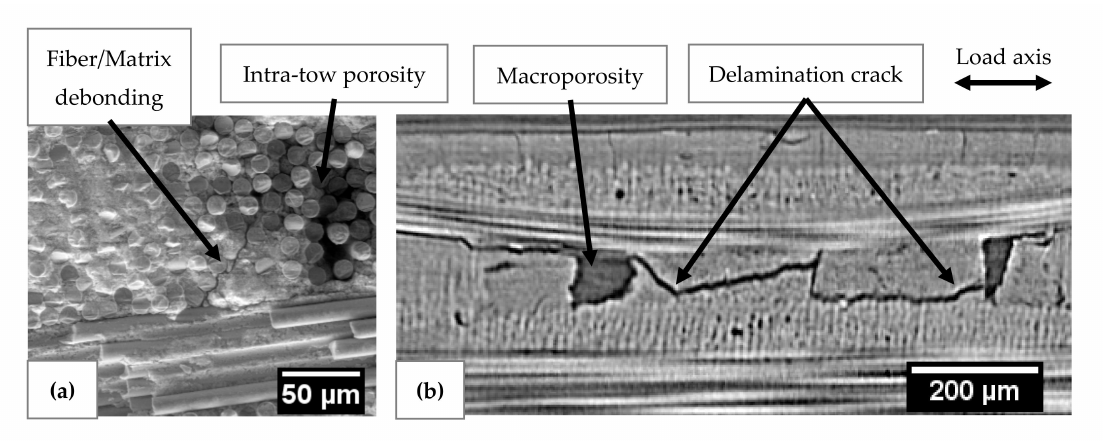
Figure 12. ( a ) In-situ SEM observation revealing intra-tow fiber / matrix debonding ( σ normalized = 0.2); ( b ) In-situ 2D µ -tomographic reconstruction showing crack delamination ( σ normalized =